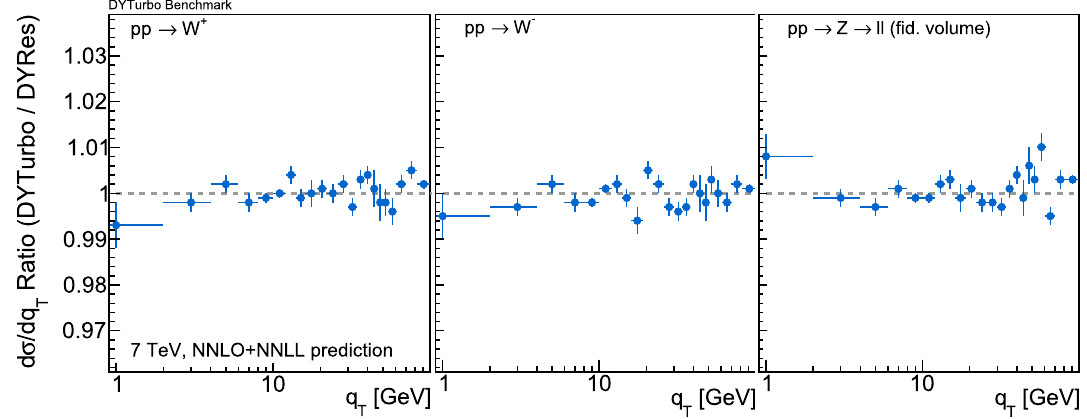
√ s = 7 TeV as a function of the boson transverse momentum for full-lepton phase √ s = 8 TeV. The results for DYNNLO are taken from Ref.